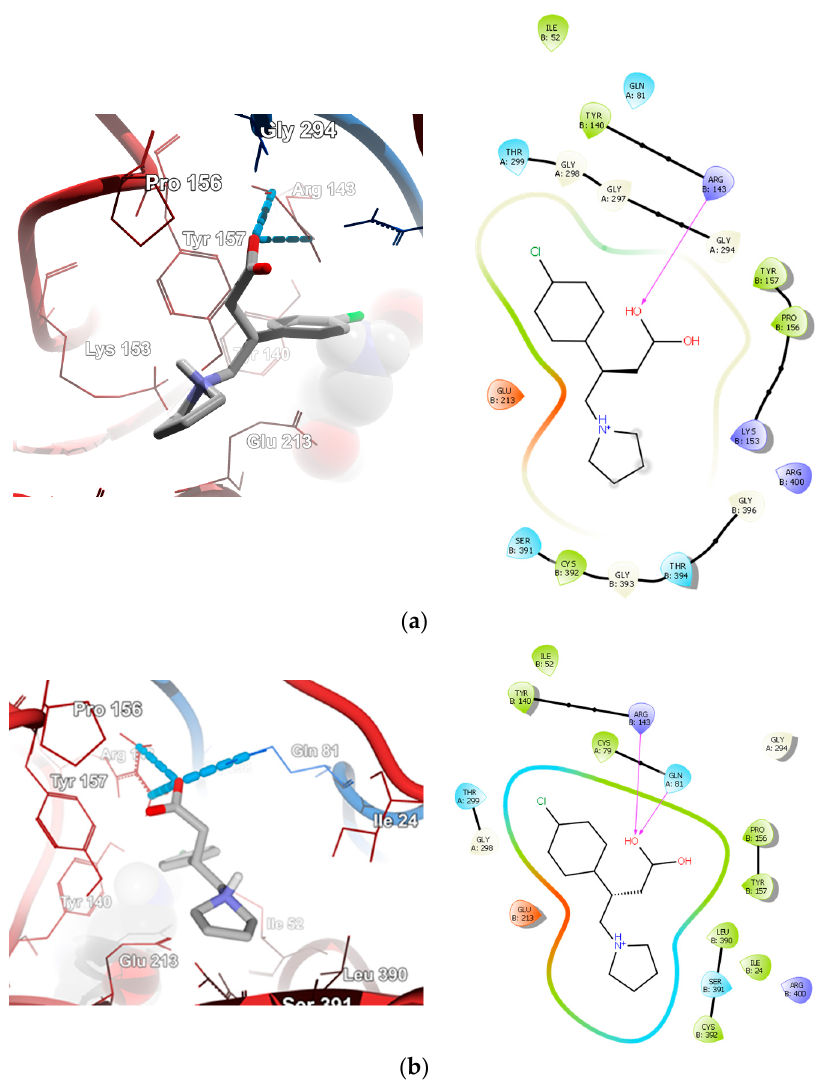
Figure 11. ( a ) ( R )- 19a hydrogen bond interactions (blue dashed lines) with Pseudomonas GABA-AT; ( b ) ( S )- 19a hydrogen bond interactions (blue dashed lines) with Pseudomonas GABA-AT. The PLP prosthetic group is shown as spacefill model. The images were made with Molegro programs.